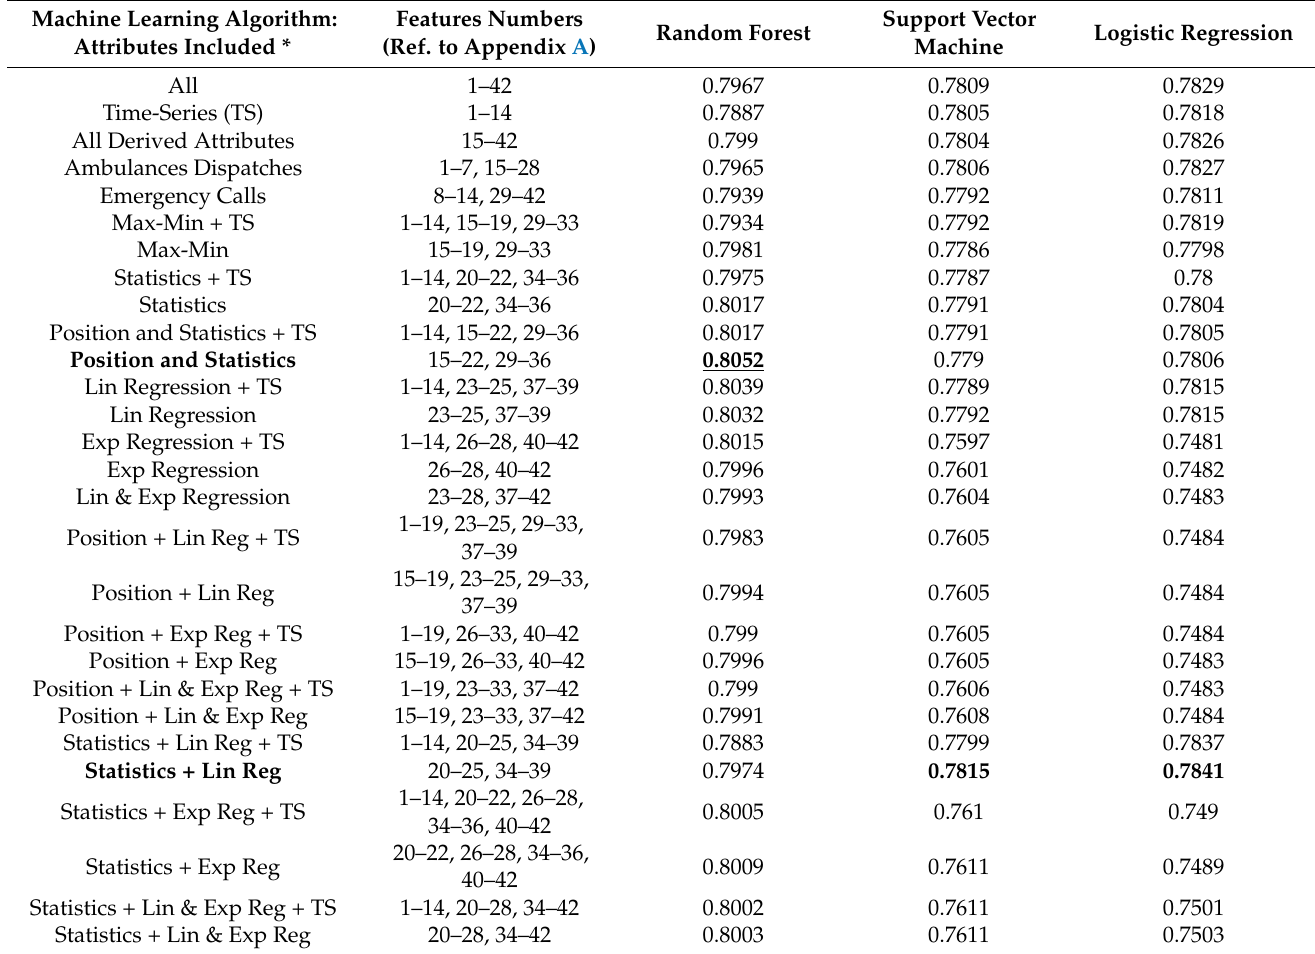
Table 3. Optimization of a machine learning algorithm for a daily binary classification of territorial districts in the condition of the active spreading of the COVID-19 epidemic (‘1’) or no diffusion of the epidemic (‘0’) on the basis of ambulances dispatched and calls received by the EMS department in Lombardy, Italy, between 1 January 2020 and 13 March 2022. The table reports the final scores of dif- ferent combinations of machine learning algorithms and attribute combinations (see Appendix A for a detailed list), computed by averaging the different metrics (and their distributions indicators) on the 10-fold cross-validation protocol, according to the defined weights (see Table 2). In bold, the highest results reached for each algorithm are highlighted, while the overall best result is also